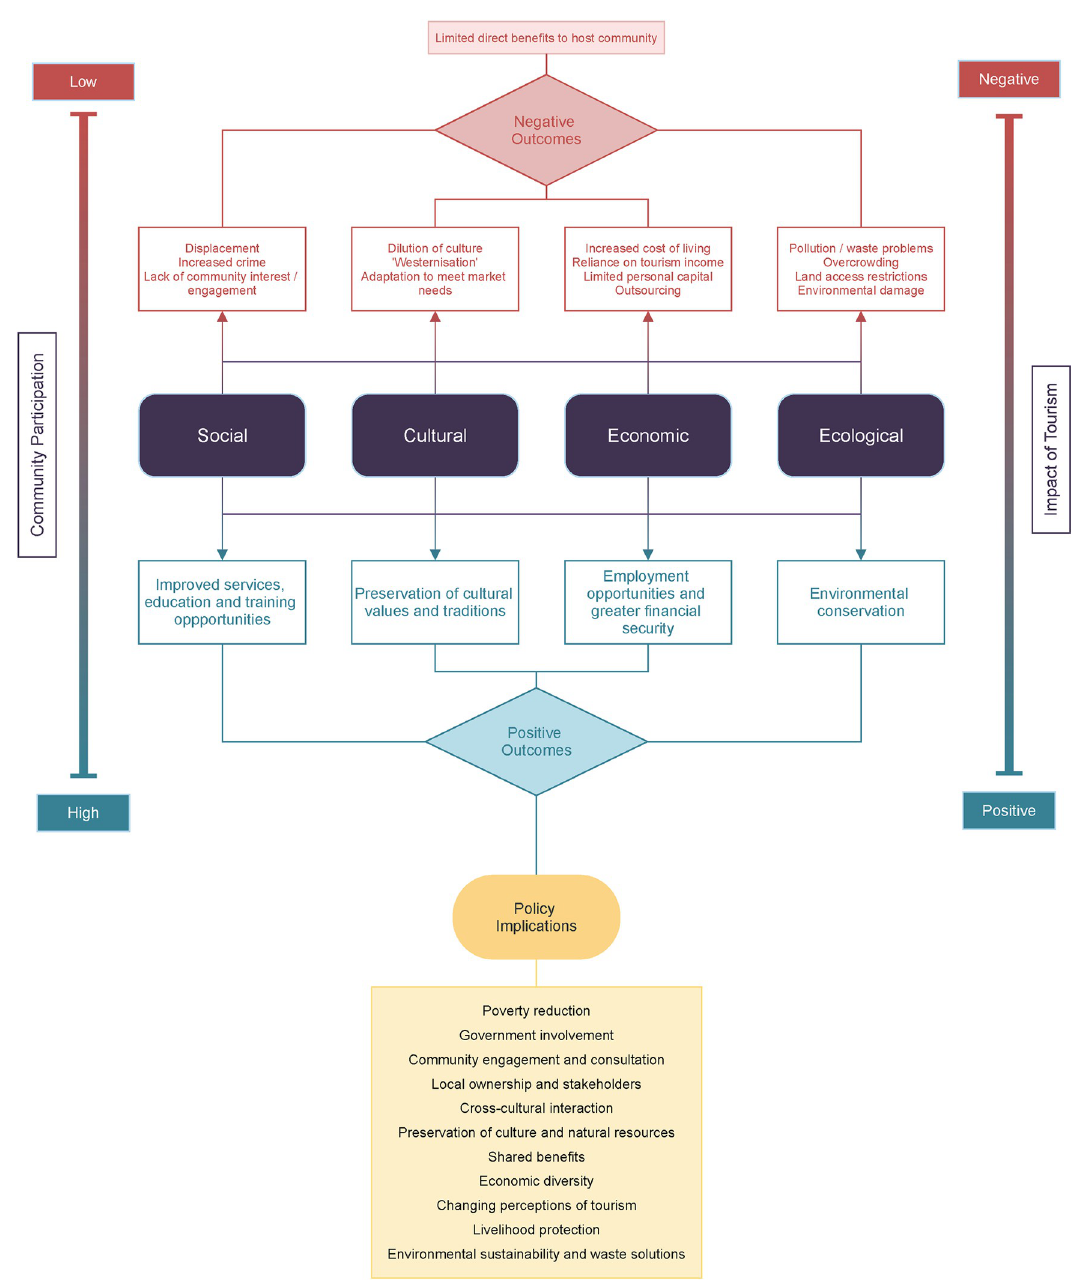
Fig 2. Theoretical framework and conceptual model of emerging research